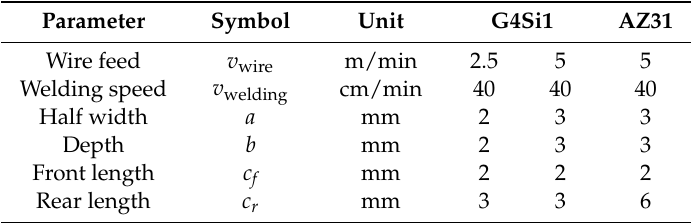
Table 1. Geometric parameters for describing the melt pool. Parameter Symbol Unit Parameter Wire